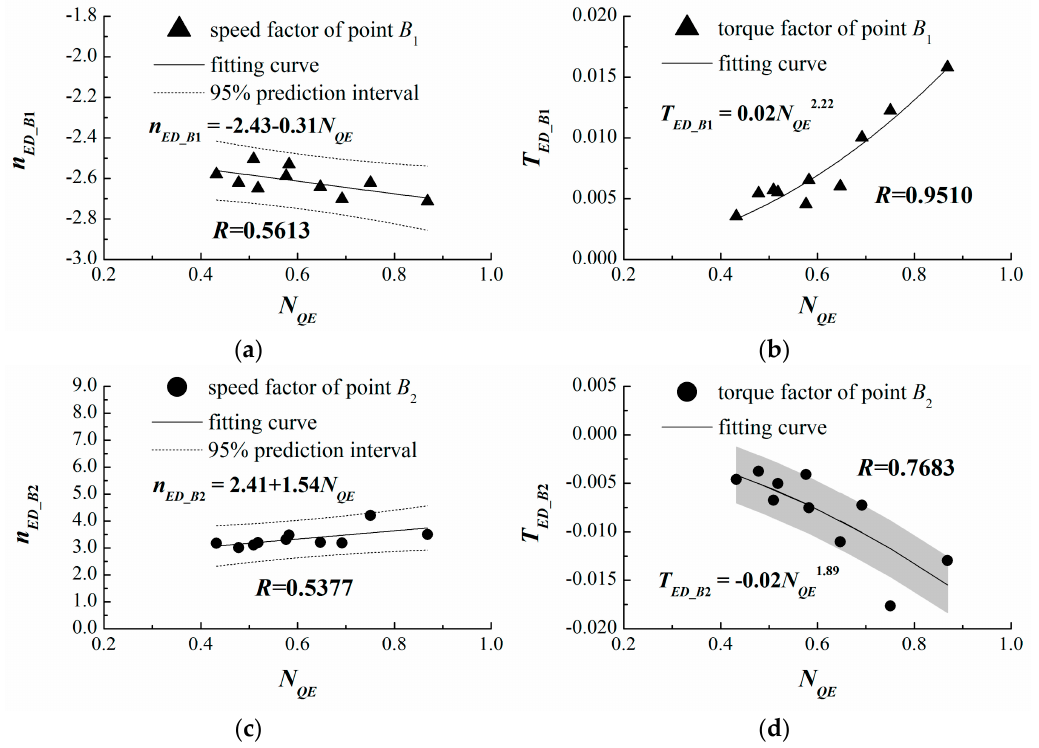
N and the characteristic parameters of point B 1 and point B 2 : Figure 7. The relationship between QE Figure 7. The relationship between N QE and the characteristic parameters of point B 1 and point B 2 : . ( a ) n ED _ B 1 − N QE ; ( b ) T ED _ B 1 − N QE ; ( c ) n ED _ B 2 − N QE ; ( d ) T ED _ B 2 − N QE